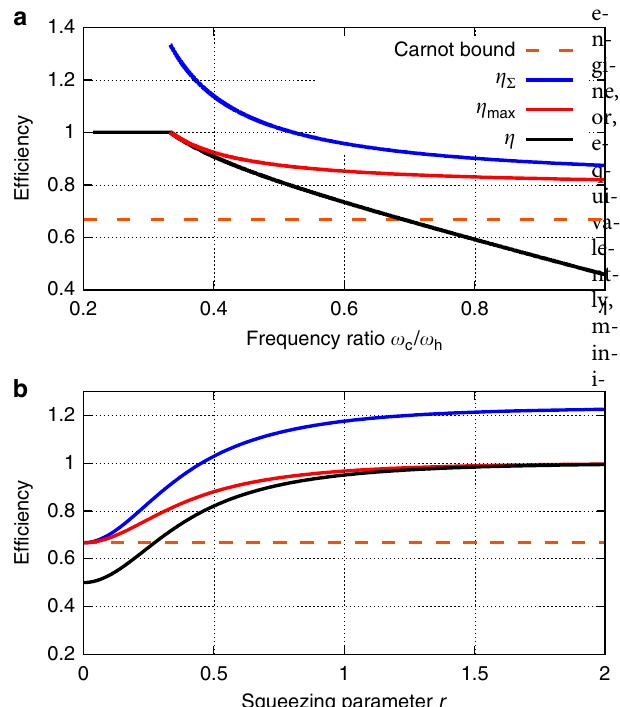
Fig. 8 Ef fi ciency bounds for the Otto-like cycle. Actual ef fi ciency η and alternative ef fi ciency bounds (the explicit expressions are summarised in Methods ‘ Expressions used in Fig. 8 ’ ) for an Otto-like cycle implemented with a harmonic-oscillator working medium and a squeezed thermal bath as a function of a the frequency ratio and b the squeezing parameter. The bounds only hold in the regime E d ; c (cid:5) 0 (see text). Parameters: T h = 3 T c and a squeezing parameter r = 0.5 and b oscillator frequencies ω c / ω h =